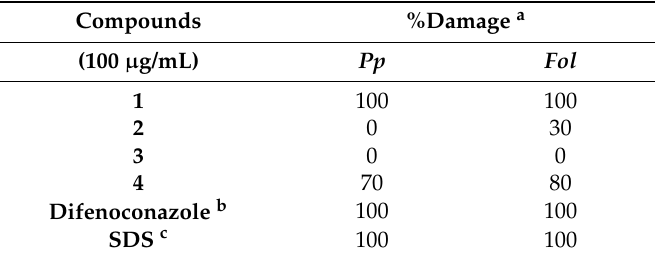
Table 3. Cellular leakage effects of compounds 1 – 4 against oomycete Pp and fungus Fol .